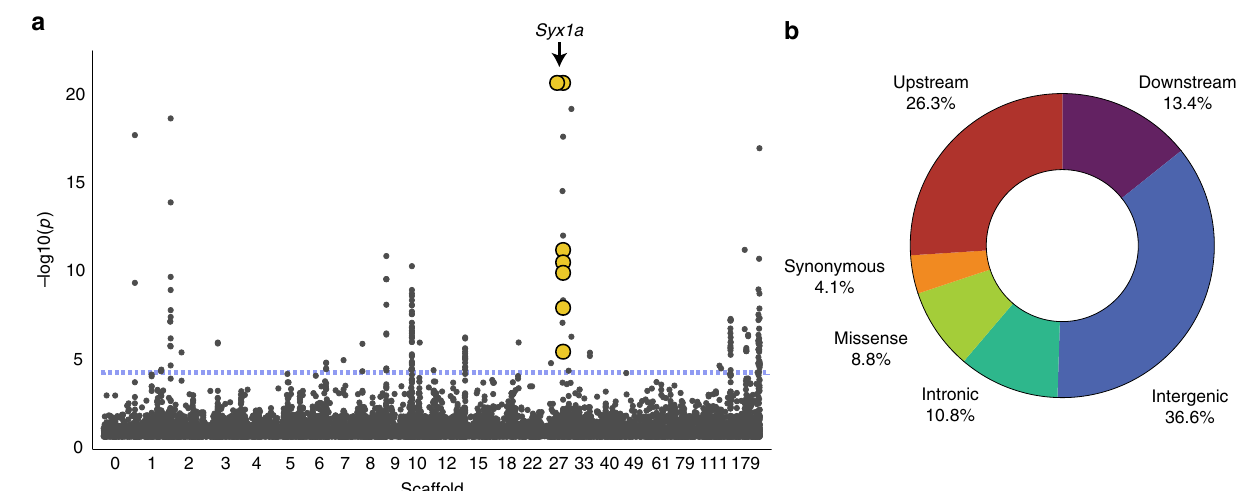
Fig. 3 SNPs associated with social behavior and their genomic location. a Manhattan plot of the genome-wide associations ( n = 71 social, 72 solitary bees). Each point represents a single SNP and its -log10 p -value (FDR-corrected for multiple testing). Only SNPs with FDR < 0.2 are included. SNPs associated with syntaxin 1a are highlighted (yellow). b Multiple SNPs are associated with variation in social behavior in L. albipes ( n = 194 SNPs), ~40% of these occur in regulatory regions neighboring coding exons (i.e., n = 45 within 5 kb upstream of the transcription start site; n = 28 within 1 kb downstream of the last